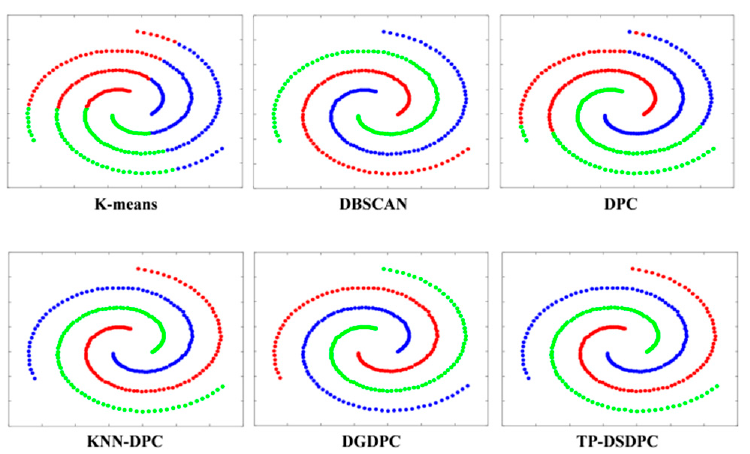
Figure 8. Clustering results on Spiral.